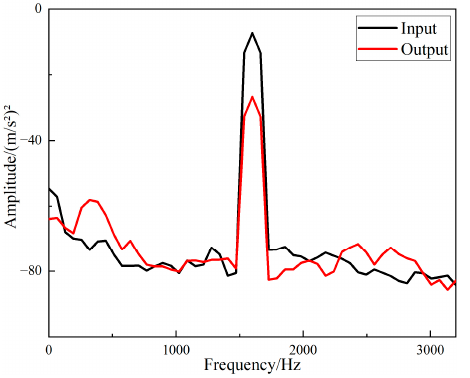
Figure 22. Frequency domain input and output signal of periodic structure support.